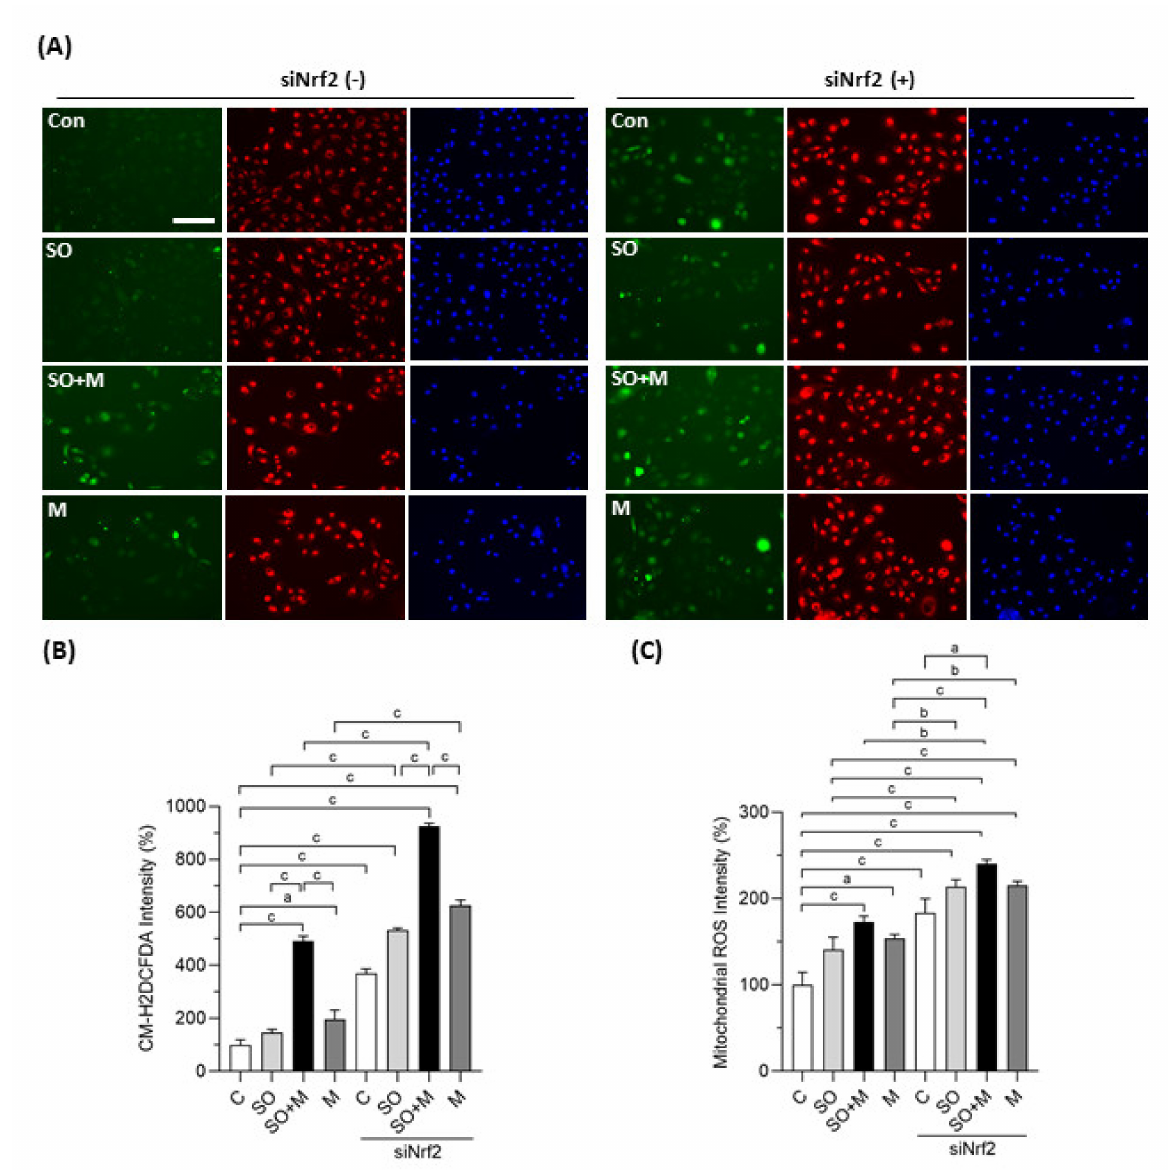
Figure 1. Cellular and mitochondrial ROS generation in HK-2 cells. ( A ) Production of cellular reactive oxygen species (ROS) in human proximal tubular cells (HK-2 cells) was detected by a CM-H 2 DCFDA green fluorescence probe (green color). Mitochondrial ROS was detected by a MitoTracker Red CMXRos fluorescent probe (red color). Cell nuclei were stained with Hoechst 33342 (blue color). Scale bar = 150 µ M. ( B ) Quantified results of the cellular ROS. ( C ) Quantified results of the mitochondrial ROS. The cells were stimulated with 1 µ g/mL melamine (M) and/or 0.01 mM sodium oxalate (SO) for 6 h. Con and C: control cells without treatment; siNrf2: the cells treated with Nrf2 small interference RNA for 24 h. Data are mean ± SE ( n = 3). a: p < 0.05; b: p < 0.01; c: p <